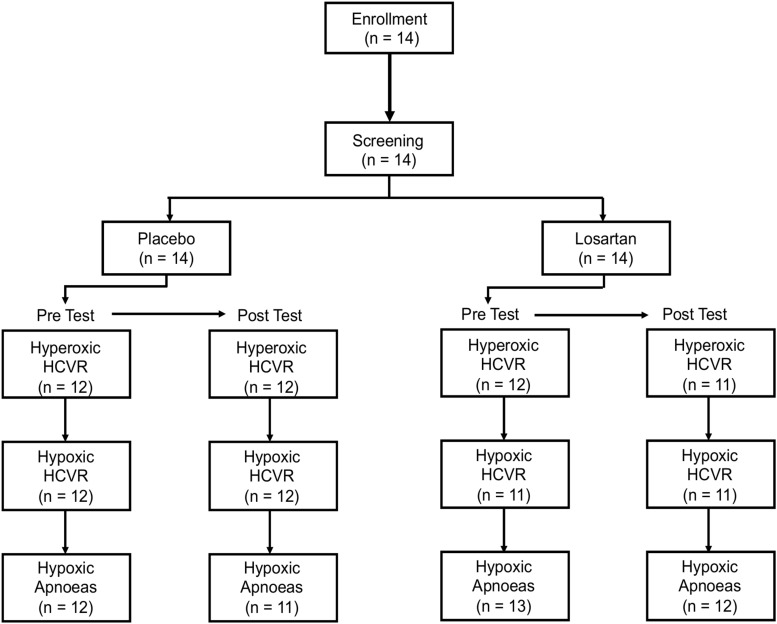
Participant flow chart.